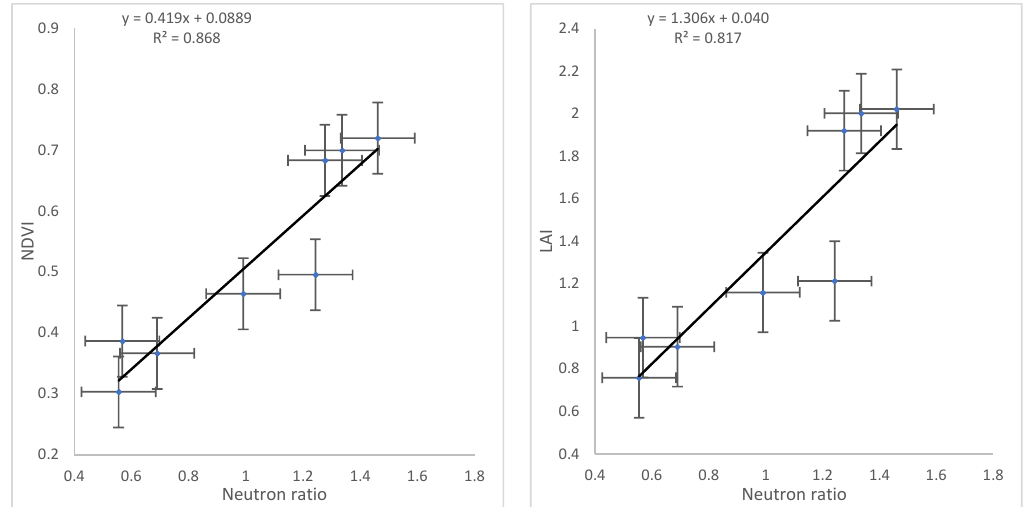
Figure 11. Scatterplots of the ground CRNS neutron ratio (x-axis) against NDVI (y-axis), and the neutron ratio (x-axis) against LAI (y-axis).